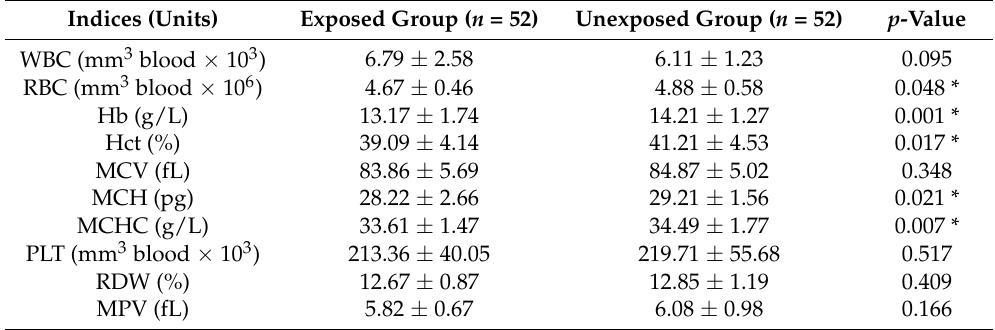
Table 3. Comparison of complete blood count tests between exposed and unexposed groups (mean ± SD). Indices (Units)